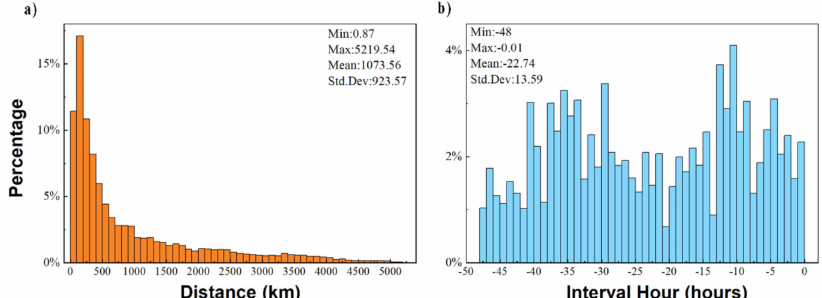
Figure 17. ( a ) The histograms and summary statistics obtained for distances from the epicenter of the seismic-related data. ( b ) The histograms and summary statistics obtained for time interval before the time of the earthquake. The percentage is that of the counts of each bin divided by the sum of counts of all